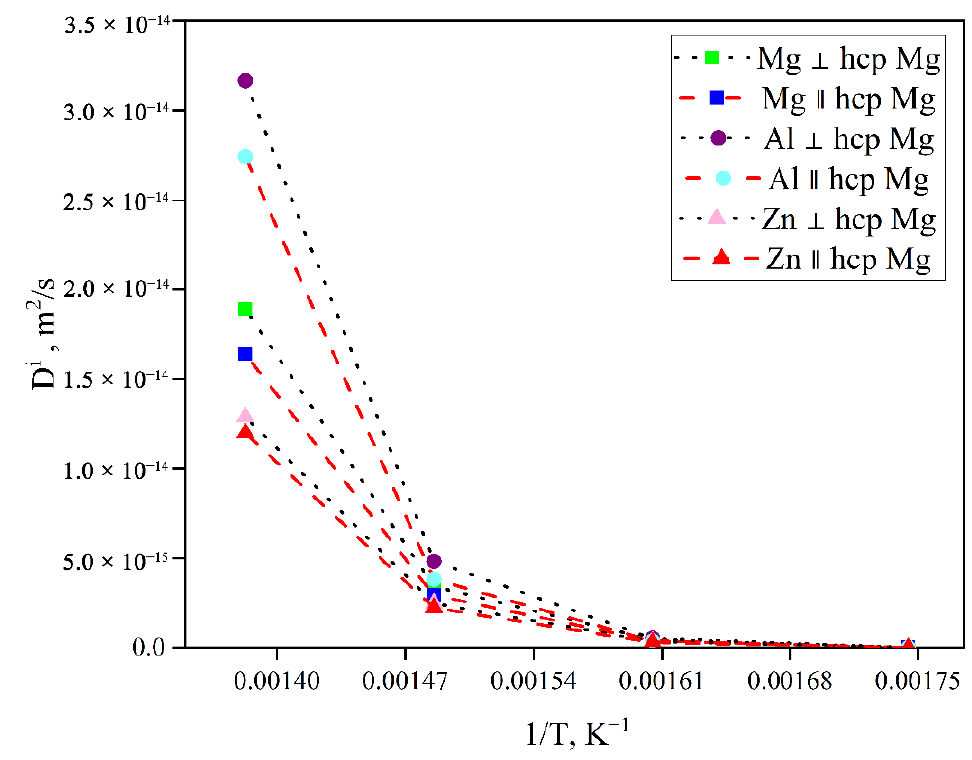
Figure 16. The solute atoms diffusion coefficients of Mg, Al, and Zn in hcp–Mg along or perpendicular to the c -axis.